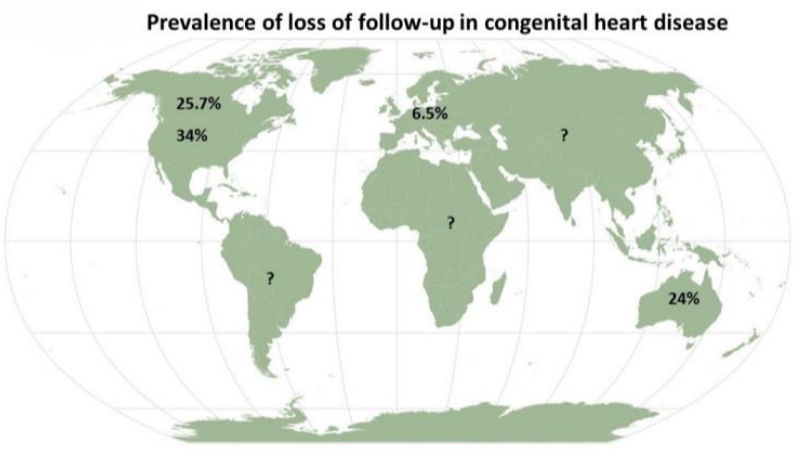
Figure 2. Continental prevalence of loss of follow-up.